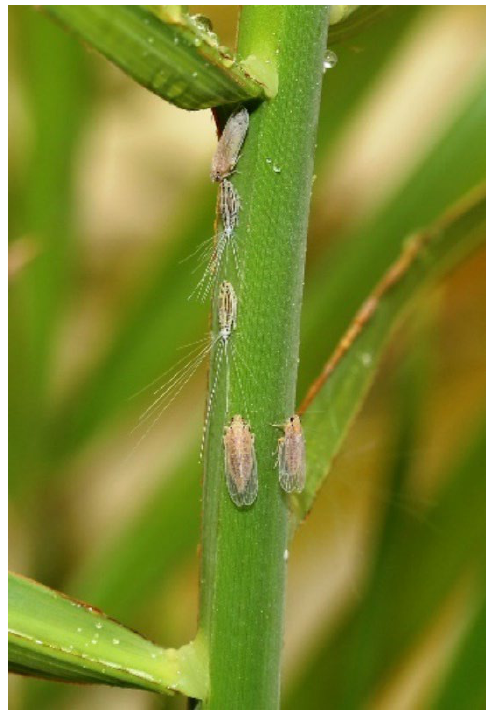
Figure 1. Dubas bug ( Ommatissus lybicus de Bergevin) nymphs and adults on date palm. Feeding disrupts photoassimilate flow and hinders phloem transport by interfering with sugar and nitrogen delivery to cells, as in the case of aphids [6,9]. Endophytic ovipo-